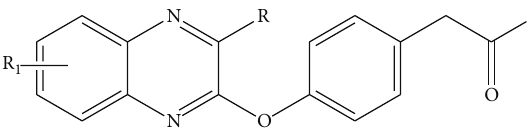
Figure 24: Chemical structure of compound 59a – v .